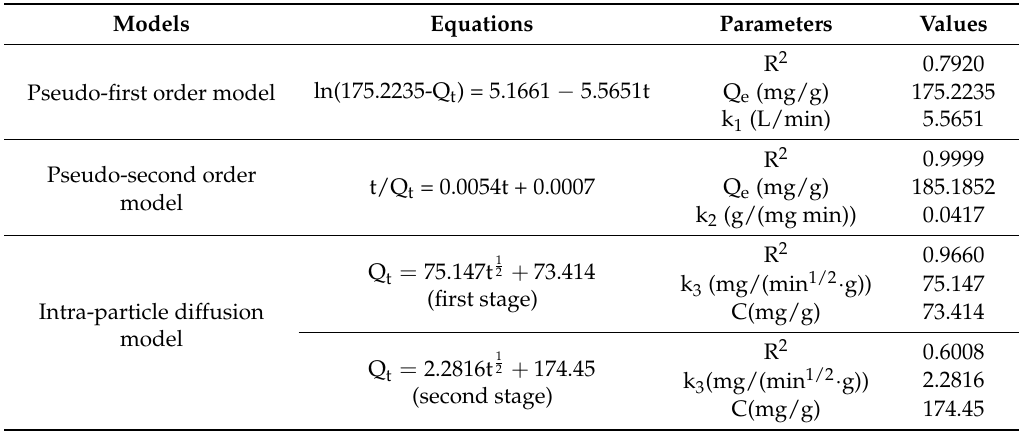
Table 3. Adsorption kinetics modeling and parameters for PMFs on HPD 300 resin.